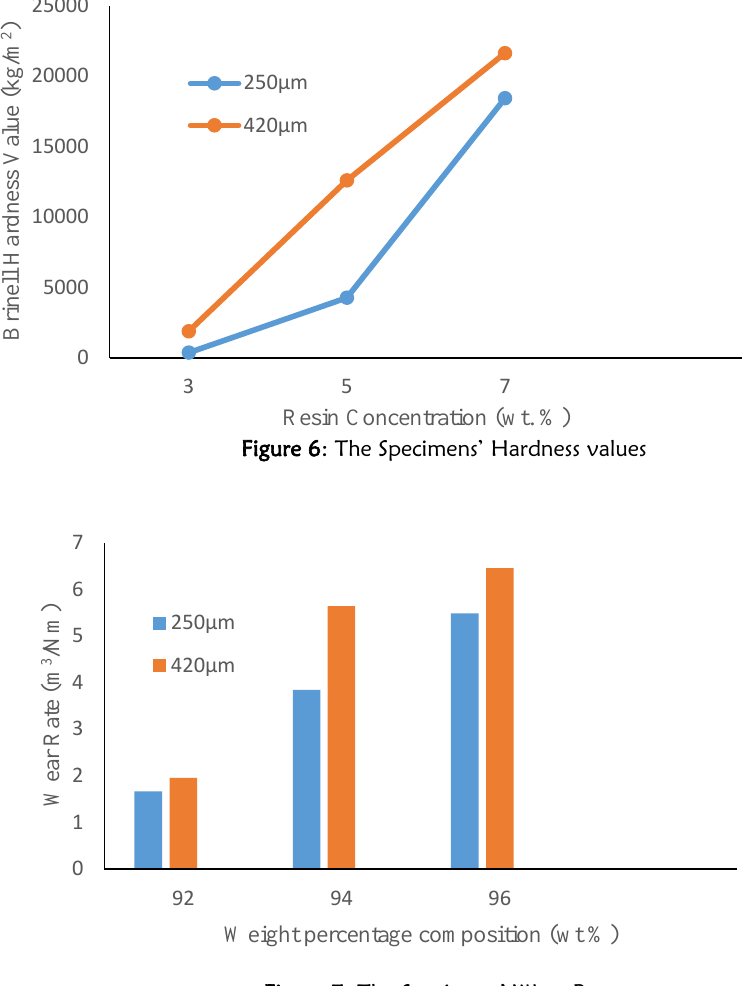
Figure 7 : The Specimens’ Wear